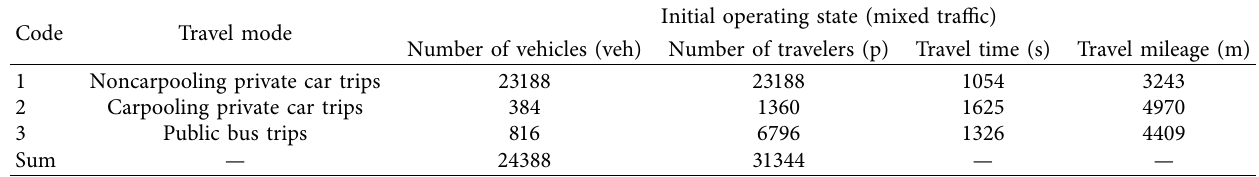
Table 9: Travel time and travel mileage of different travel modes in the initial operating state (mixed traffic).